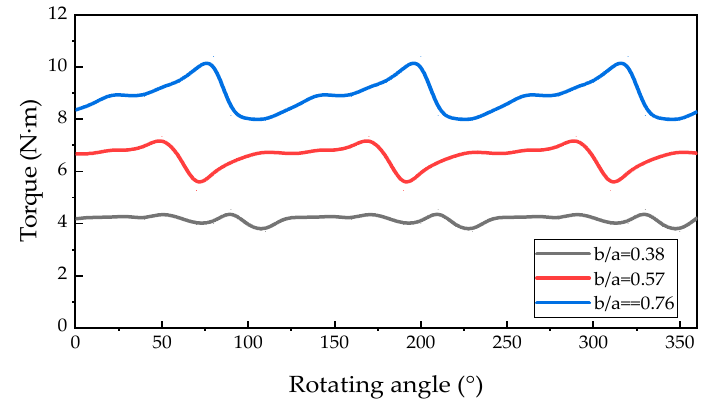
Figure 14. Torque comparison curve with different ratios of the major axis to the minor axis.